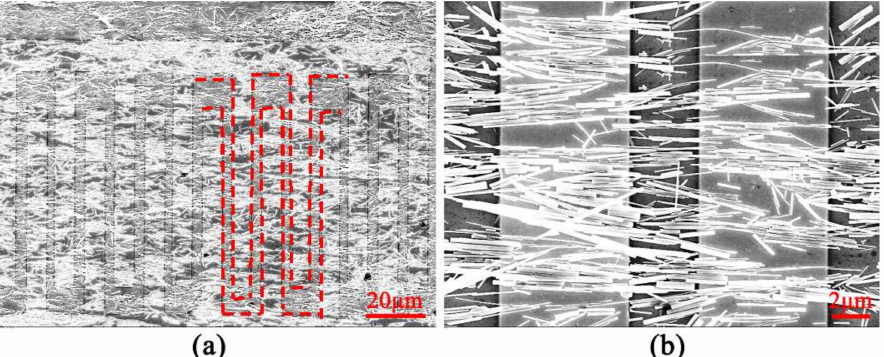
Figure 4. FESEM images of the device: ( a ) ZnO nanowires device with finger shape Au electrodes after the process of nanowire assembly on the Si substrate (red dotted line denotes the finger shape electrodes); and ( b ) the zoom-in image of the